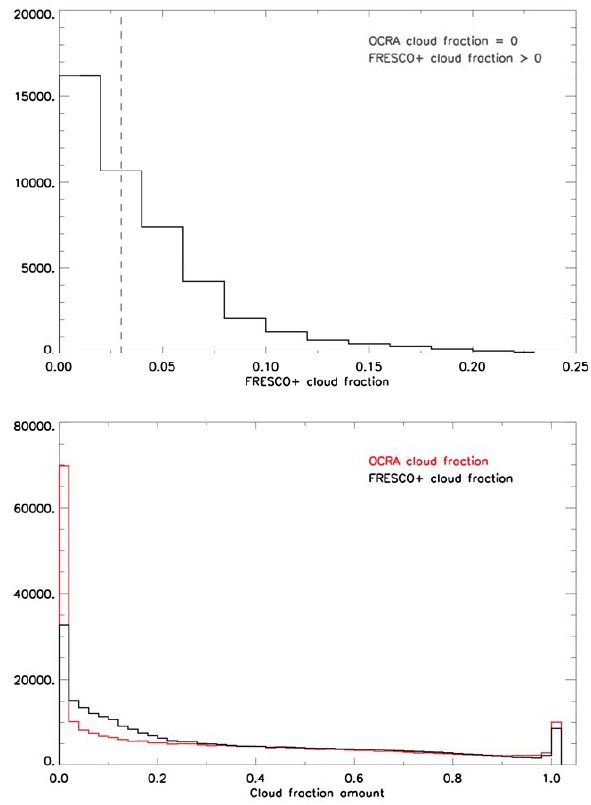
Fig. 18. Comparison between OCRA and FRESCO + cloud cover amounts, for where OCRA cloud cover fraction equals zero. For 80% of the selected cases where OCRA cloud cover fraction equals zero, the FRESCO + cloud cover amount is more than zero and indicates that some form of cloud is still present in the (OCRA) selection. The dashed vertical line in the top figure indicates the median FRESCO + cloud cover fraction of 0.03. The bottom figure indicates the number of cloud fraction cases of the OCRA (red) and FRESCO + (black) cloud cover cases.